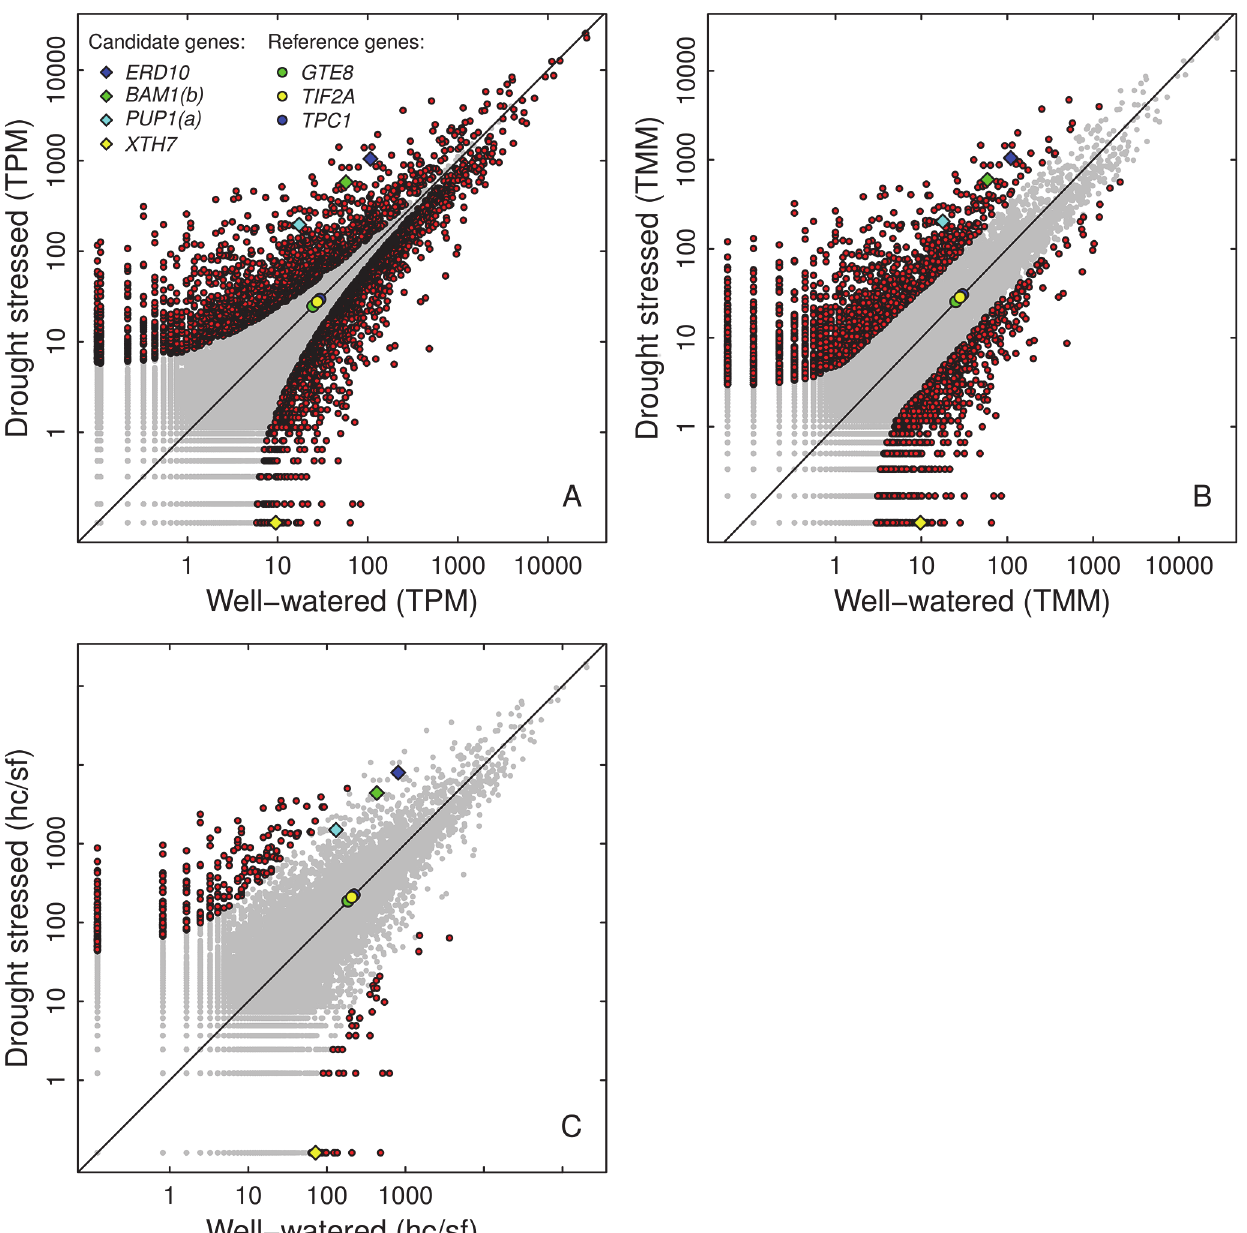
Fig 2. Scatter plots of the MACE results and subsequent analyses of differential expression for DEGseq (A), NOISeq (B) and DESeq (C). Each plot contains all identified transcripts (grey dots), as well as the analysis-specific DE transcripts (red dots). Further, the candidate genes validated via RT-qPCR are shown, as well as the corresponding stably expressed reference genes. The x- and y-axis give the transcript count in the well-watered and the drought stressed pool, respectively. Counts are normalized differently for the three analyses: tags per million (TPM) for DEGseq, trimmed mean of M-values (TMM) for NOISeq and hitcount/size factor (hc/fc) for DESeq. Transcripts falling on the straight line (90° bisecting line) are equally expressed in both pools. Transcripts above the line are up-regulated in response to drought stress, while those below the line are